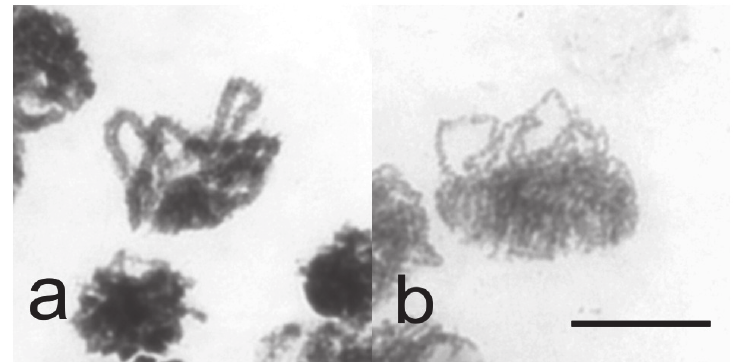
Figure 3. Synapsis and synaptic alignment of chromosomes in C. myrtilli ( a ) Pachytene, synapsed chromosomes in bouquet orientation in chiasmate male meiosis ( b ) Presynaptic alignment of leptotene chromosomes in male meiosis lacking chiasmata in bouquet orientation. Bar equals 10